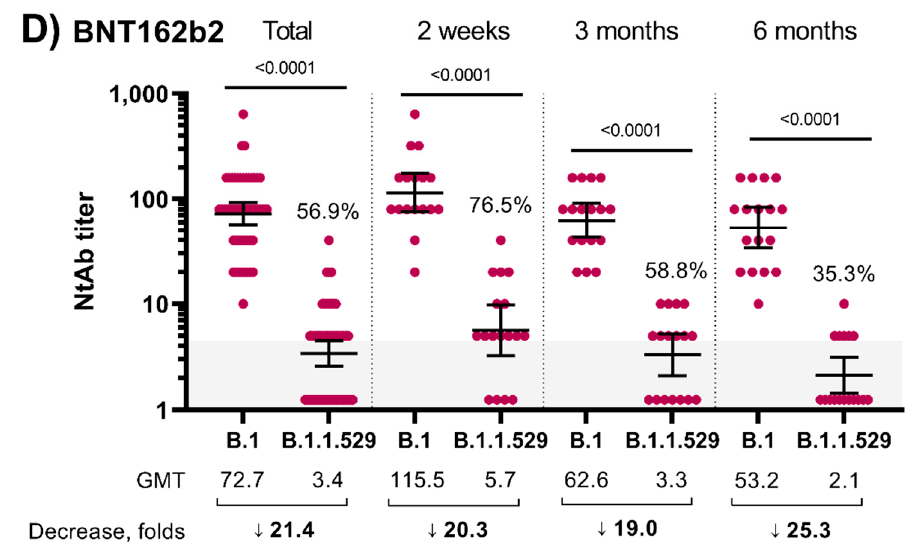
Figure 1. ( A )—RBD-specific IgG titers in vaccinated individuals, median and 95% CI; ( B )—NtAb titers against SARS-CoV-2 B.1 in vaccinated individuals, geometric mean titer and 95% CI, C, D—NtAb titers against SARS-CoV-2 B.1 (Wuhan D614G) and B.1.1.529 (Omicron) variants in Sputnik V- ( C ) and BNT162b2 ( D )-vaccinated individuals, geometric mean titer and 95% CI, %—part of sera with detectable NtAb. p -value was determined by Wilcoxon test. Grey box—limit of detection. Values below the limit of detection were assigned a value of NtAb